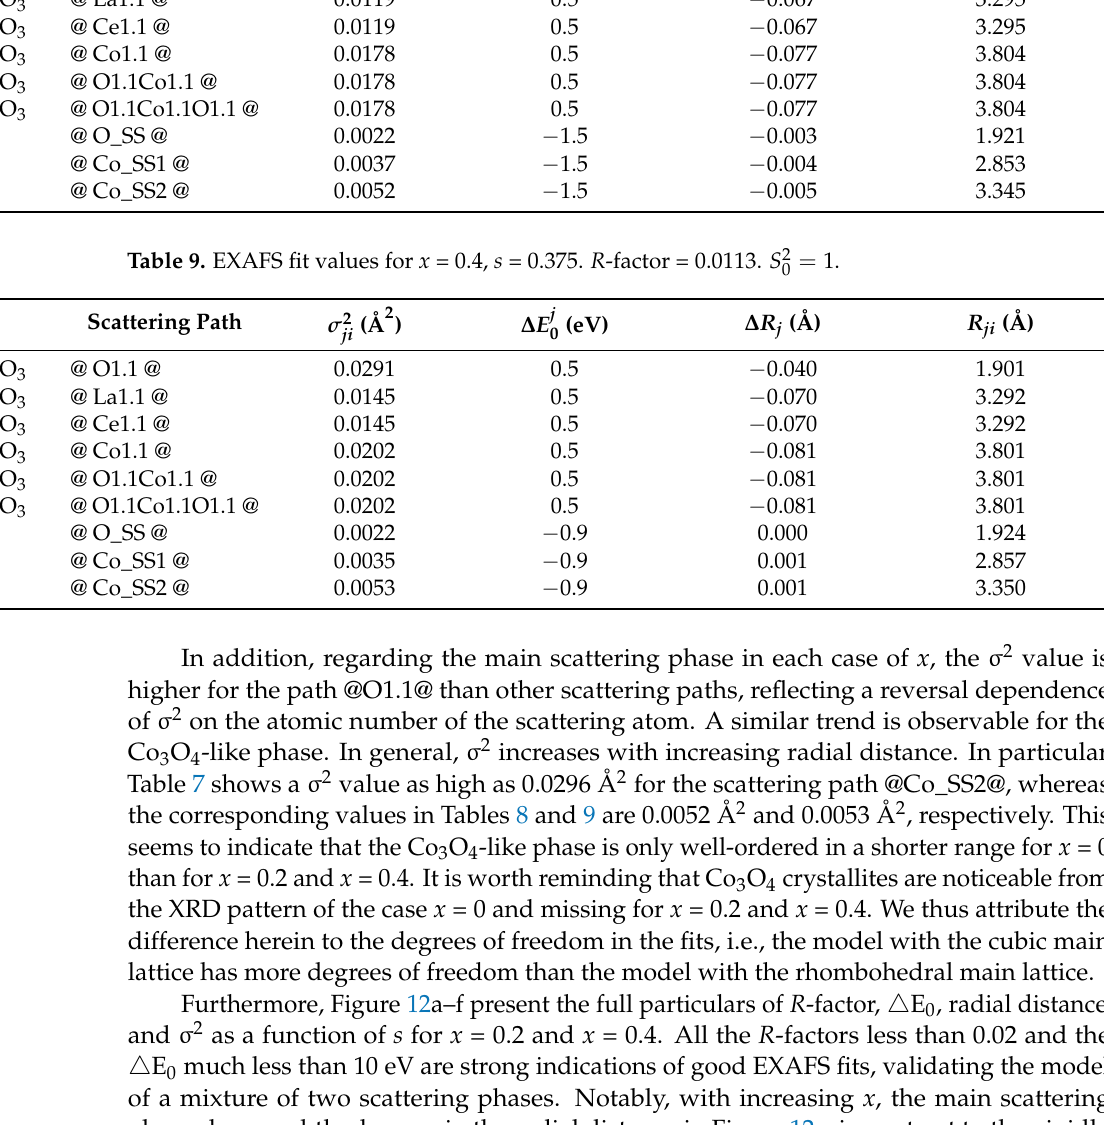
Table 8. EXAFS fit values for x = 0.2, s = 0.25. R -factor = 0.0096. S 2